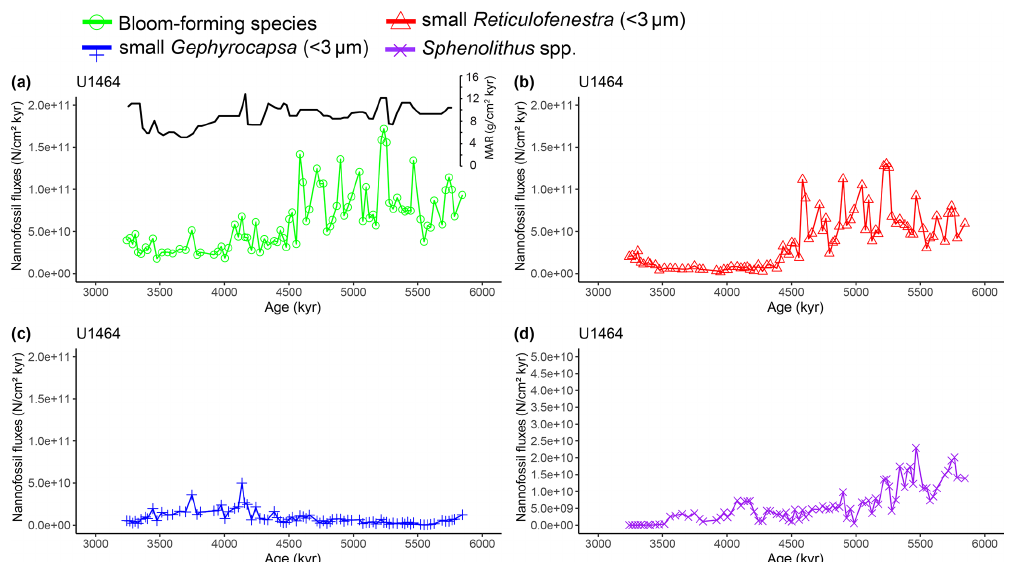
Figure A6. Latest Miocene to early Pliocene nannofossil fluxes (NAR; Ncm − 2 kyr − 1 ) of the dominant calcareous nannofossil species at IODP Site U1464. (a) Bloom-forming species ( < 5µm Reticulofenestra and < 3µm Gephyrocapsa ; green circles) with inset bulk sediment MAR (gcm − 2 kyr − 1 ; black line), (b) small ( < 3µm) Reticulofenestra (red triangles), (c) small ( < 3µm) Gephyrocapsa (blue plus signs), and (d) Sphenolithus spp. (purple crosses). Error bars of maximum replication error (15%; Bordiga et al., 2015) were too small and therefore impaired the visual inspection of the figure. However, they are available as part of the source data of the paper. Note the different y axis scale in panel (d) .